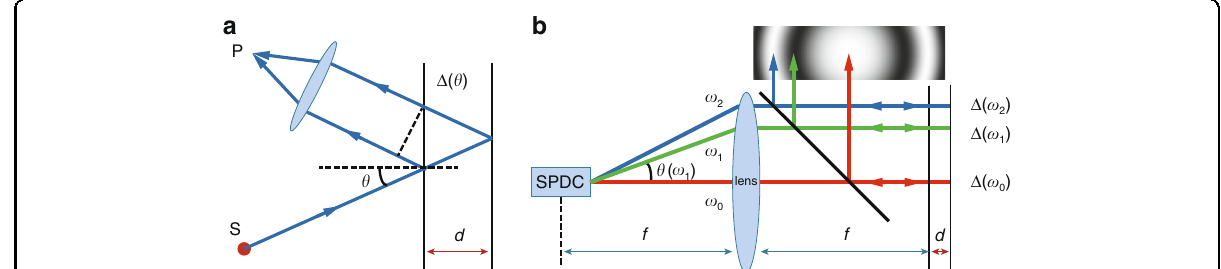
Fig. 1 Schematics. a Traditional equal-inclination interference. Two rays from a point source S interfere at the point P. The phase differences for the bright or dark fringes are caused by the angular-dependent OPDs Δ ( θ ) = 2 d cos θ (where Δ denotes an OPD). b Angular-spectrum-dependent interference. The phase differences for each fringe order are caused by the frequencies ω n (where ω denotes a frequency). The OPD is given by Δ ( ω = 2 d ω n ) n/